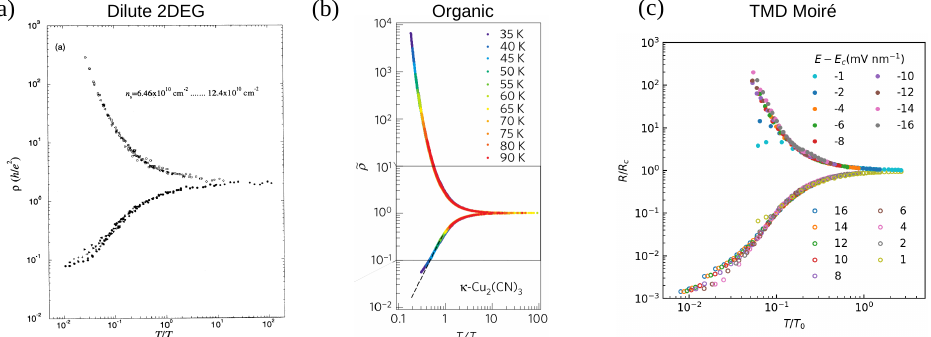
Figure 2. Critical scaling has been observed in all three experimental systems, when the resistivity is plotted versus T / T o where T o is the characteristic crossover (quantum critical) energy scale. Note that in all cases a strong “mirror” symmetry [22,23] exists between the insulating (upper) and metallic (lower) scaling branch. ( a ) In a dilute 2DEG, scaling of the bare resistivity ρ ( T ) was achieved by simply rescaling T with T o ∼ | δ | 1.6 (Adapted with permission from Ref. [24] Copyright 1995 American Physical Society); ( b ) In organic compounds, the normalized resistivity ˜ ρ is obtained by normalizing the resistivity by the critical resistivity along the Widom line. This leads to excellent scaling collapse with T o ∼ | δ | 0.60 ± 0.01 (Adapted with permission from Ref. [25] Copyright 2015 Springer Nature); ( c ) A similar approach was followed in TMD moiré bilayer MoTe 2 /WSe 2 , with similar T o ∼ | δ | 0.70 ± 0.05 (Data imported from